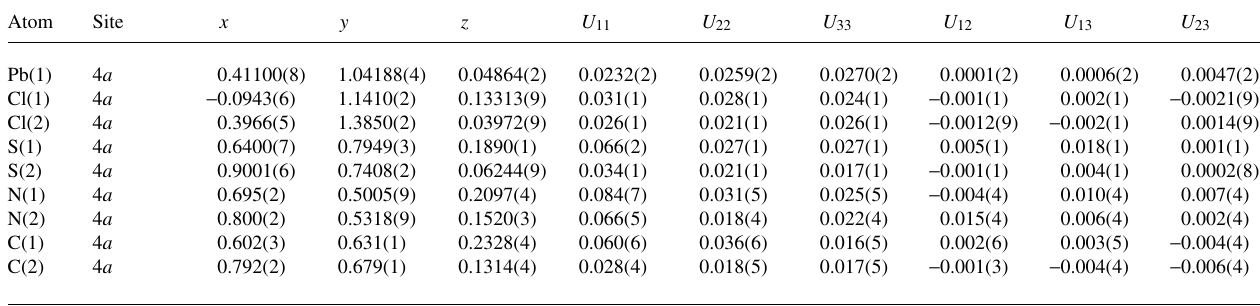
Table 3. Atomic coordinates and displacement parameters (in Å 2 )